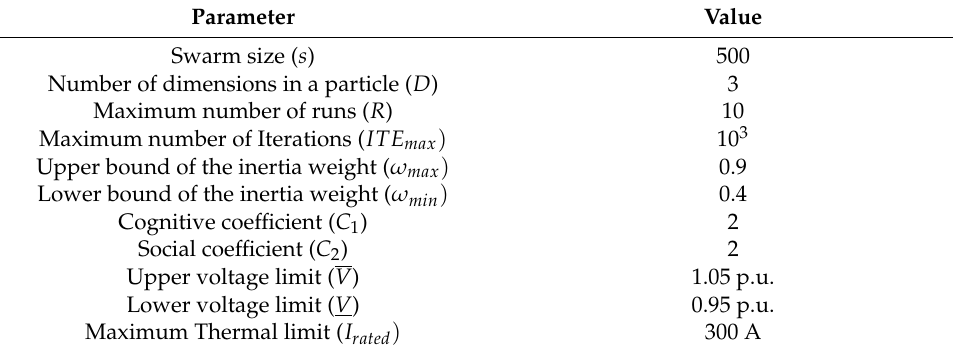
Table 2. The PSO algorithm parameters for the optimal sizing of